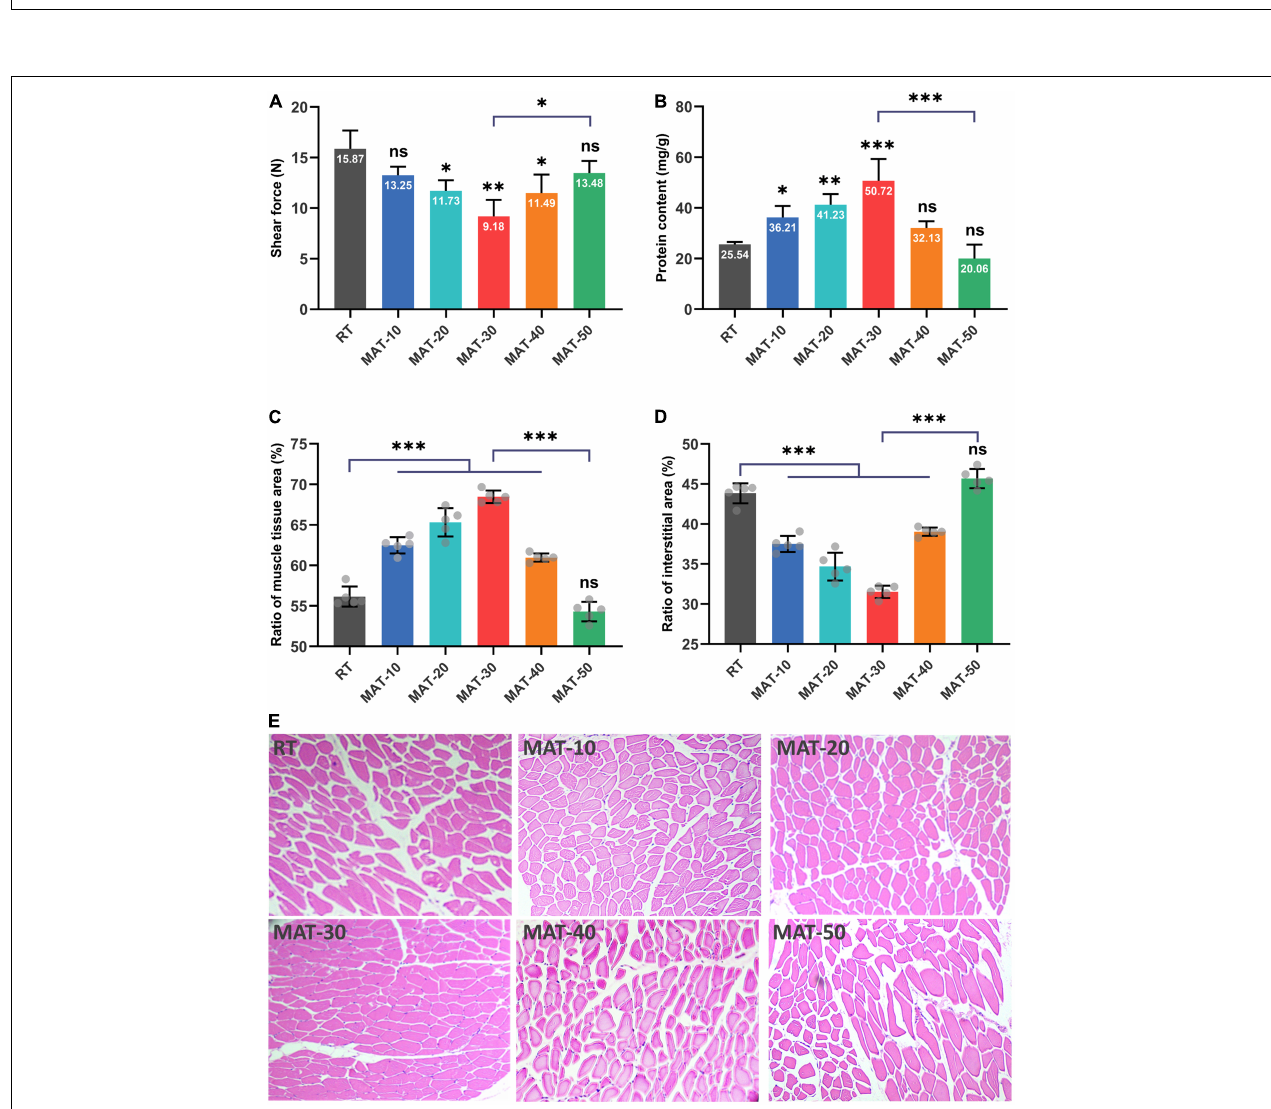
FIGURE 6 | Physicochemical quality of frozen beef with different thawing treatments. (A) Shear force value. (B) Water-soluble protein content. (C) The ratio of muscle tissue area. (D) The ratio of the interstitial area in each muscle tissue. (E) Structure of muscle fiber. ∗ indicates P < 0.05, ∗∗ indicates P < 0.01, ∗∗∗ indicates P <